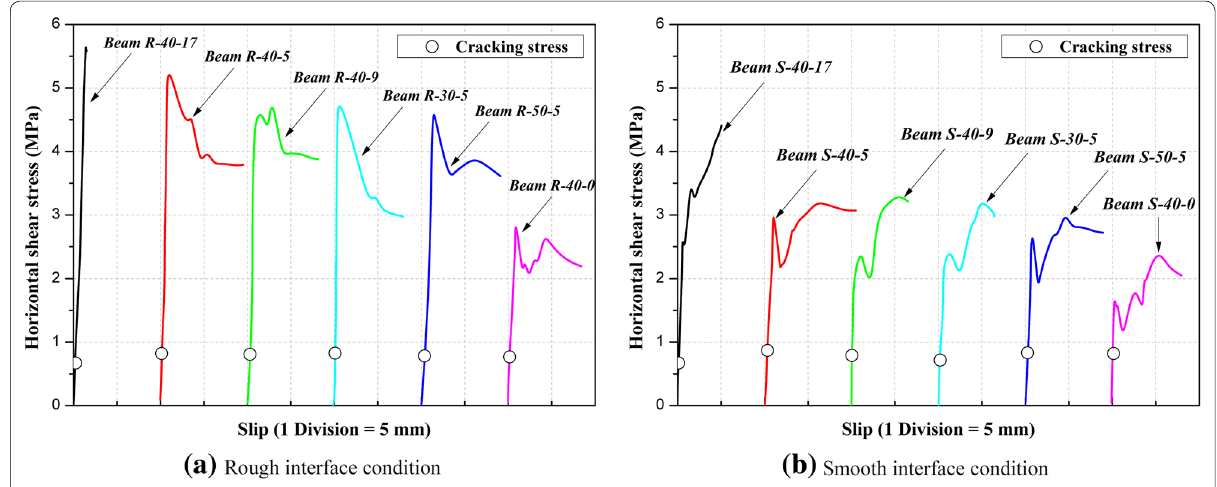
Fig. 10 Typical slip curves for different test beams.